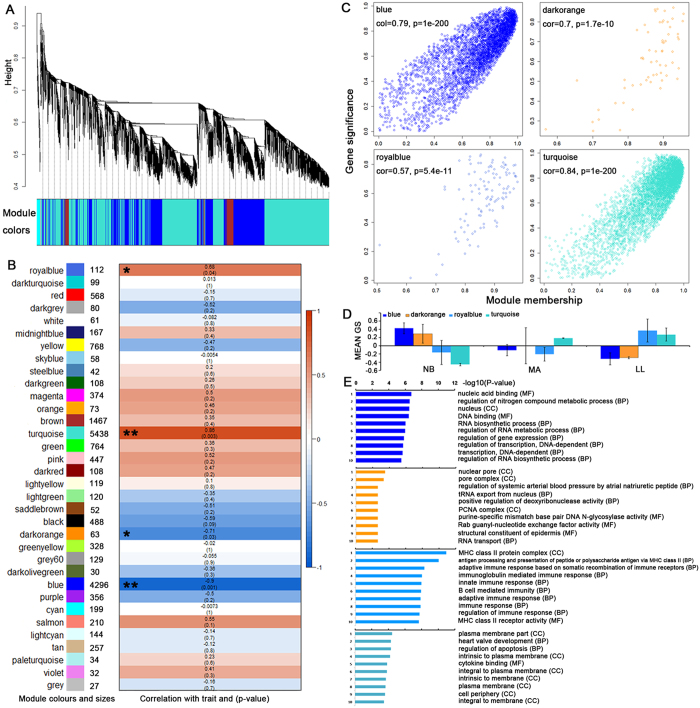
Module identification in CD4+ T cell samples and correlations of module expression with aging.(A) Clustering dendrogram of genes indicating module membership in colors. (B) Module sizes and correlation of module eigengenes with stages of aging. Module-wise correlations are provided along with the P-values of the correlation in cells colored by the strengths of the correlation. Modules significantly associated with the trait (absolute correlation > 0.5 and P-value < 0.05) are indicated with an asterisk (*). (C) Scatterplots of gene significance versus module membership for aging-associated modules, with correlations and P-values indicated. (D) Average ‘gene significance’ (GS) of genes within a specific module are summarized in the barplot for each aging stage (left to right: NB, MA, and LL). The blue and dark orange modules are positively associated with NB. The royal blue module is positively associated solely with LL. The turquoise module is negatively associated with NB. (E) The top ten GO terms were calculated with the models by functional enrichment (P-value < 0.05).